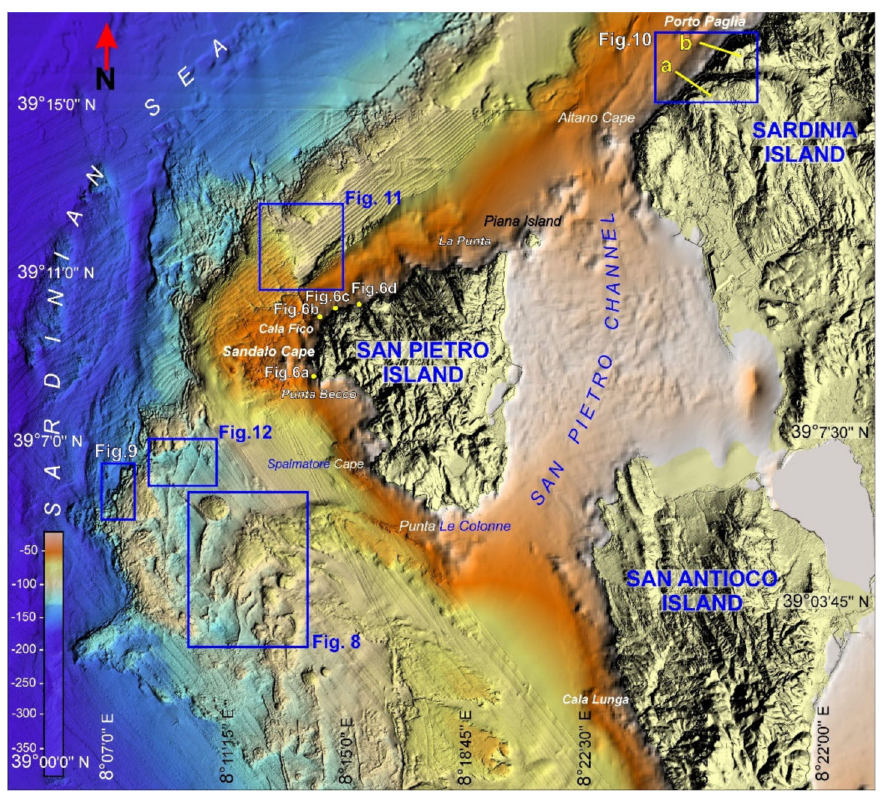
Figure 7. Location of sites depicted in the following